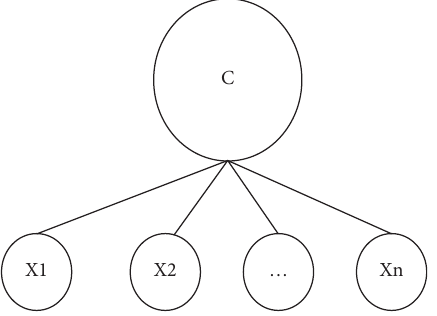
Figure 2: Basic tree enhanced naive Bayesian